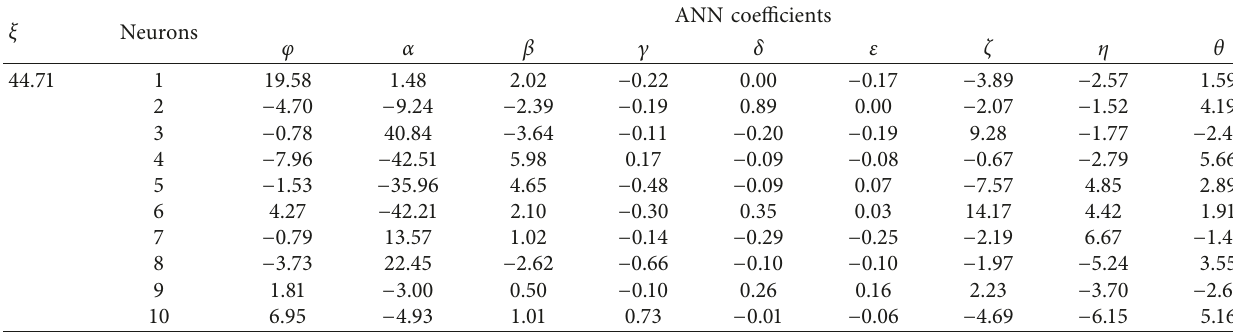
Table 10: ANN coefficients for the Marshall quotient prediction